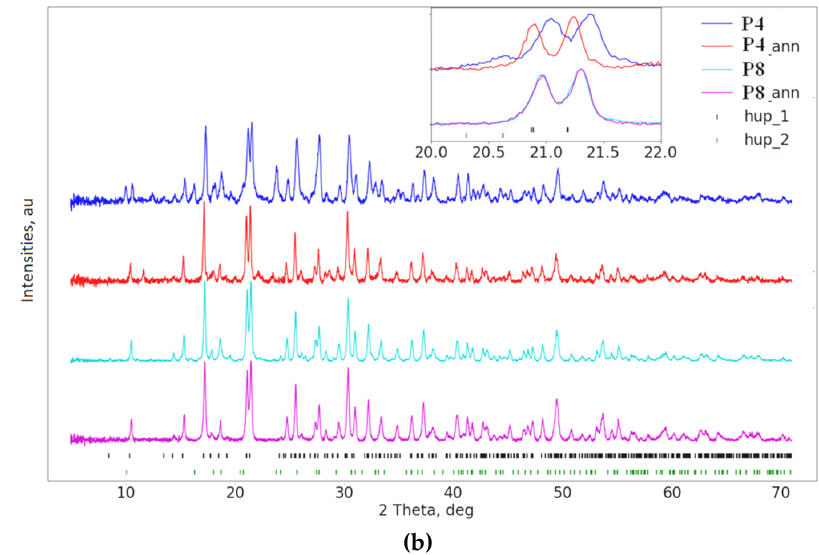
Figure 4. ( a ) PXRD patterns of the HUP—glass composites: P1 (90% Gm and 10% HUP), P2 (80% Gm and 20% HUP) and P6 (40% Gm and 60% HUP) inset in the lower sub-figure shows disappearance of one of the crystallographic phases, as well as slight reflection’s shift towards higher angles. Vertical bars show Bragg peak positions of the assigned crystallographic phases (see main text). ( b ) P4 (56% Gm and 44% HUP) and P8 (19% Gm and 81% HUP) inset plot show a shift of the reflections, indicating unit cell expansion in P4 sample upon annealing. Vertical bars show Bragg peak positions of the assigned crystallographic phases (see main text).